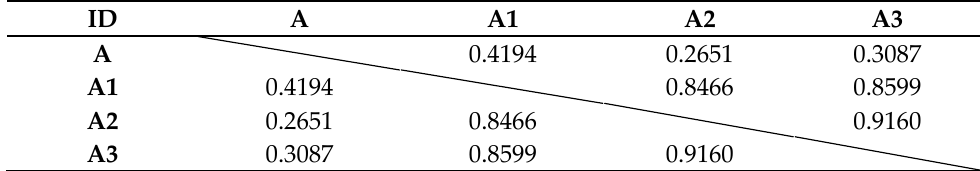
Table 6. Wind turbine SCADA wind speed correlation coefficient.